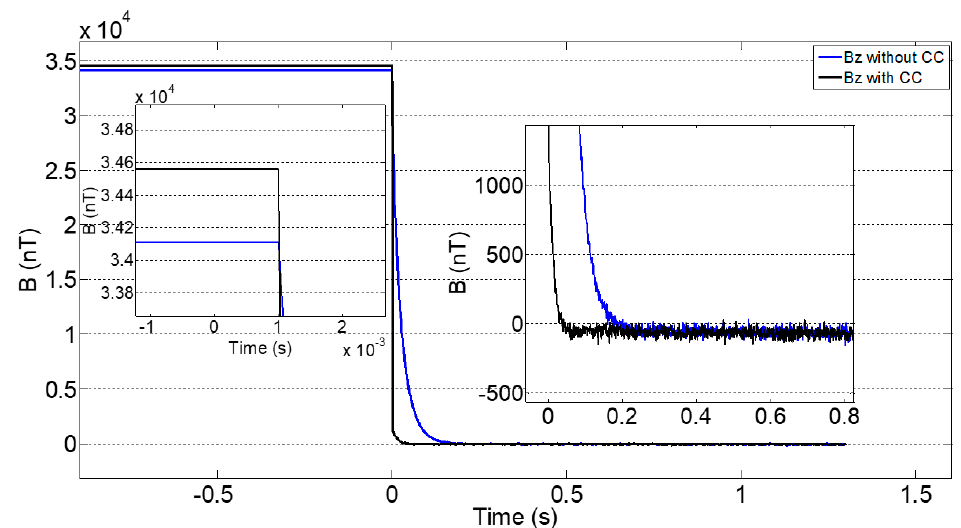
Table 4. Attenuation percentage of modulus value of B r without and with CC at different times.